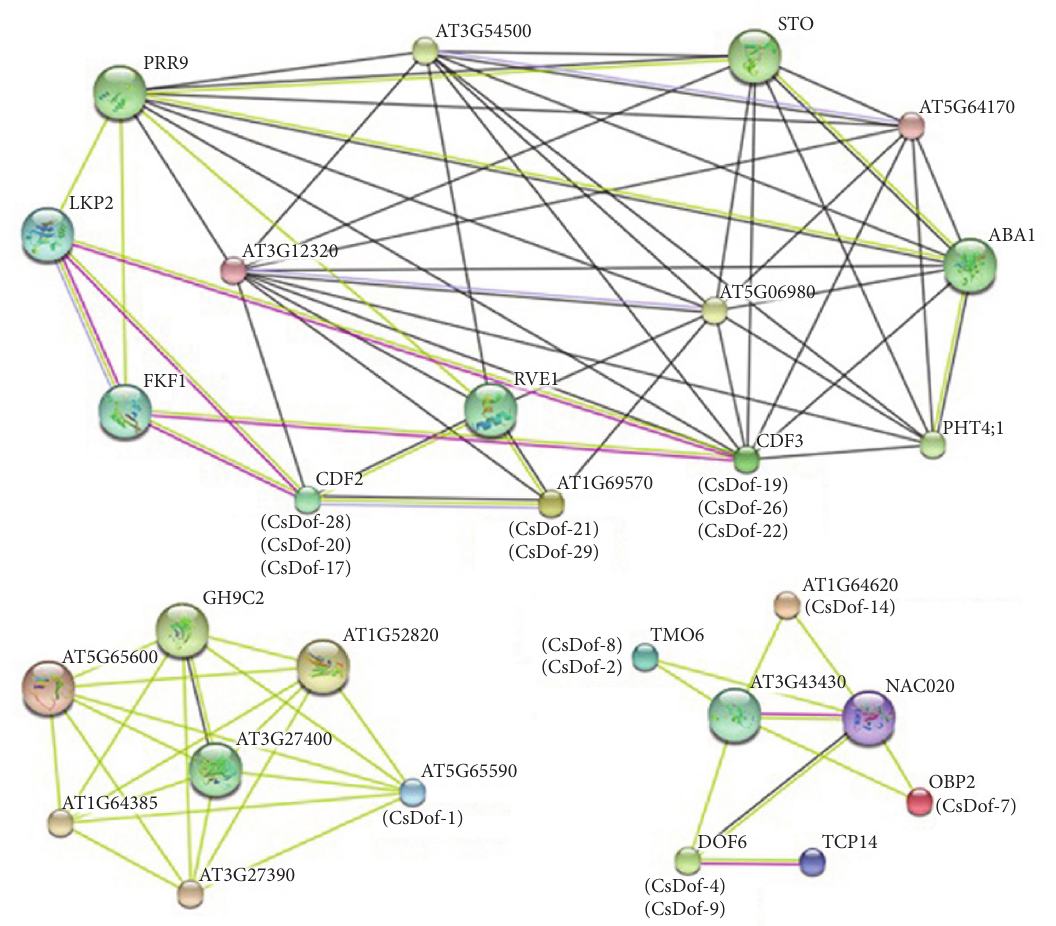
Figure 7: The interaction networks of Dofs in C. sinensis according to the orthologs in Arabidopsis.